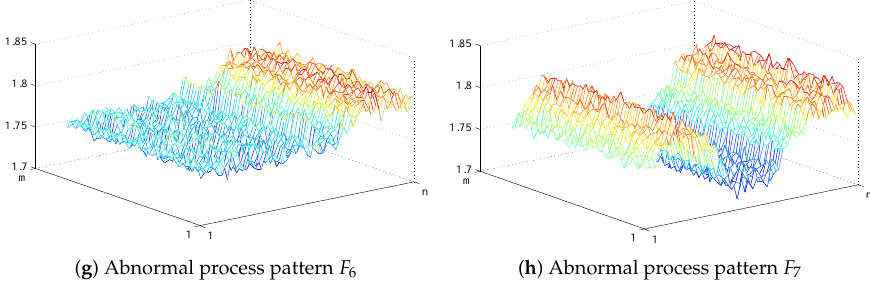
Figure 3. Normal and abnormal process patterns in the pasting